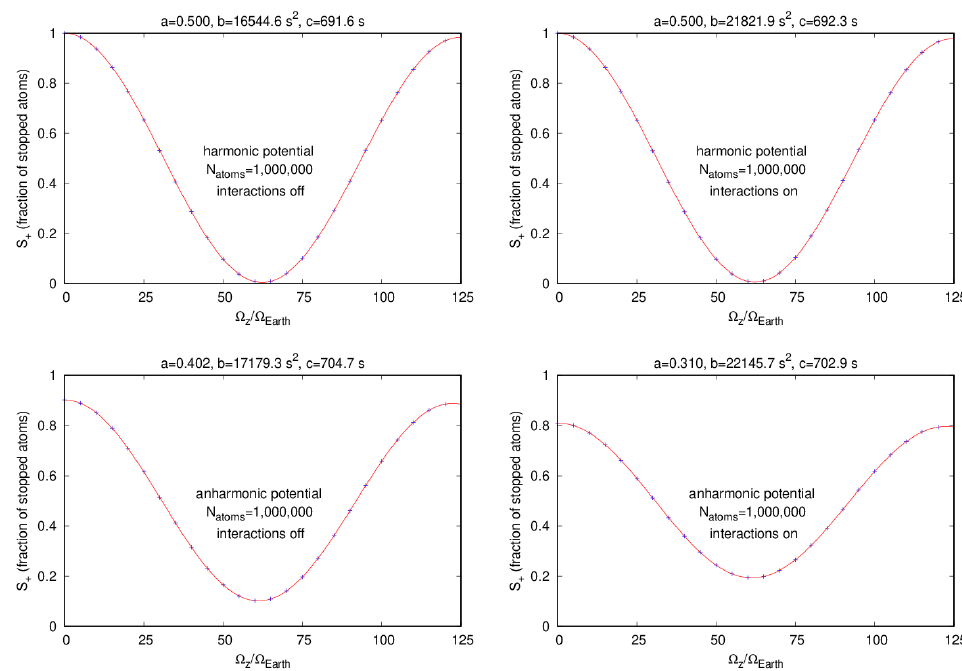
Figure 3. The fraction of stopped atoms, S + , vs rotating frame speed, Ω z , with N atoms = 1,000,000 87 Rb atoms for four different cases. Upper Left : harmonic potential and cloud–cloud interactions off; Upper Right : harmonic potential and interactions on; Lower Left : anharmonic potential and interac- tions off; Lower Right : anharmonic potential and interactions